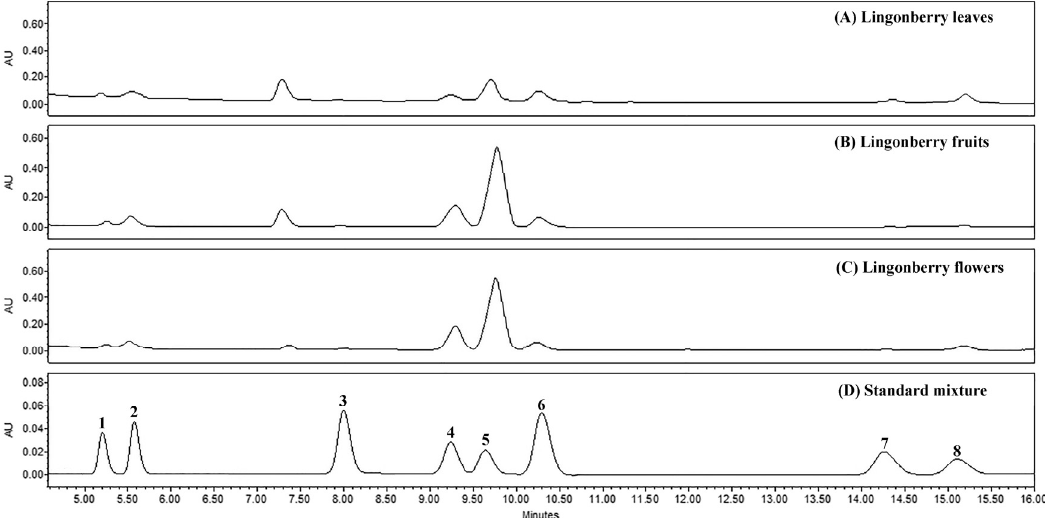
Figure 1. Representative HPLC-PDA chromatograms ( λ = 205 nm) of extracts of lingonberry ( A ) leaves, ( B ) fruits, ( C ) flowers, and ( D ) standard mixture, showing the separation of triterpenoid acids and neutral triterpenoids with chromophores. Peak assignments: 1—maslinic acid, 2—corosolic acid, 3—betulinic acid, 4—oleanolic acid, 5—ursolic acid, 6—betulin, 7—erythrodiol, 8—uvaol.